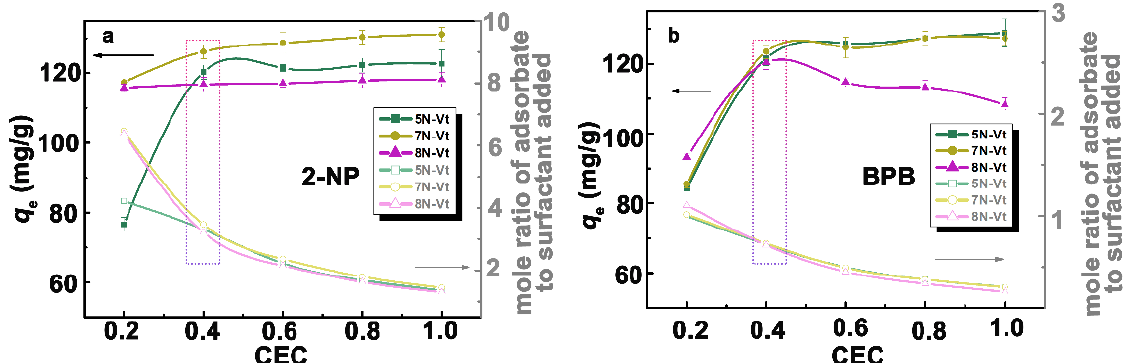
Figure 4. The effects of modifier dosage on the adsorption of 2-NP ( a ) and BPB ( b ) on organo-Vts ( C 0 = 200 mg/L).